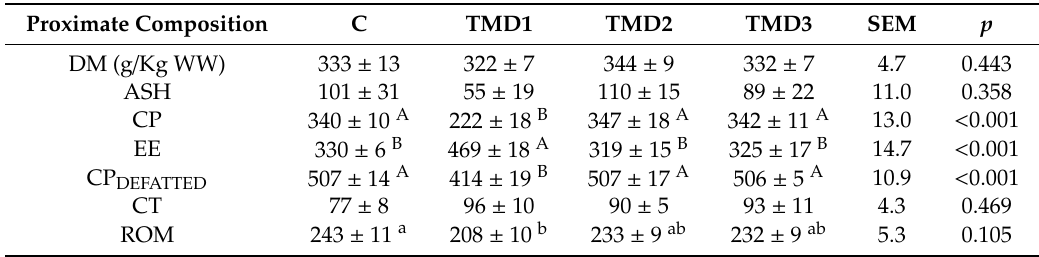
Table 5. Proximate composition (g / kg DM; unless otherwise stated) of black soldier fly prepupae (BSFPs) reared on the control diet (C) or experimental diets (TMD1–TMD3). Proximate Composition